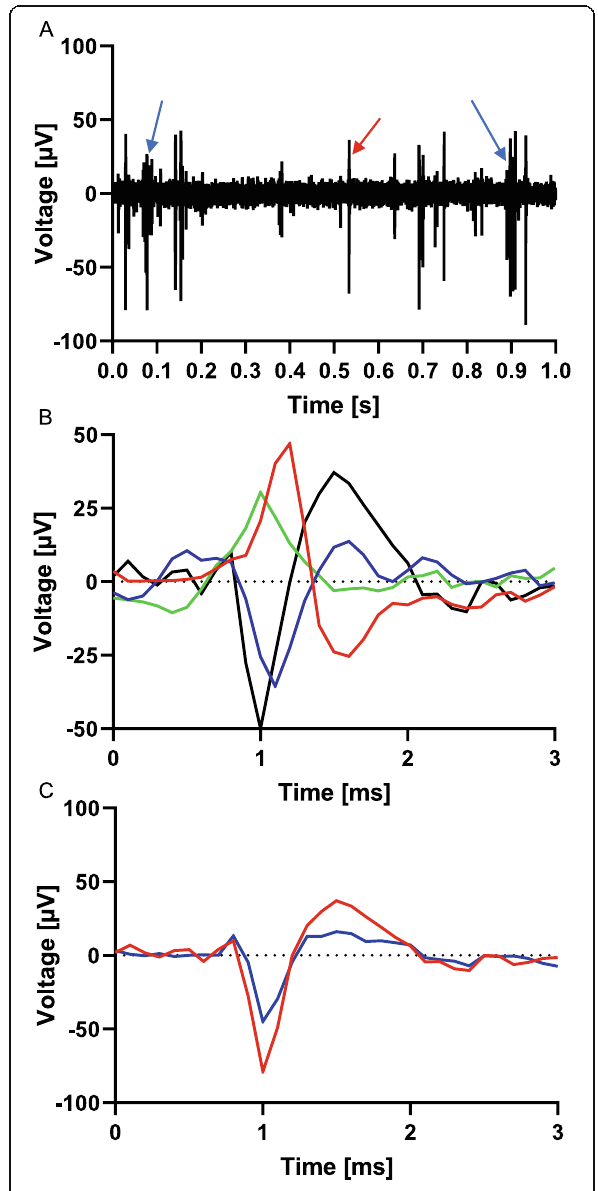
Fig. 2 Illustration of signals recorded with multielectrode arrays. A One second stream of recording from a single electrode, including single spikes (red arrow) and bursts (blue arrows). B Overlay of single spikes of different waveforms, which suggest different neuronal subtypes as the source. c Overlay of two spikes with different amplitudes but similar waveforms, either indicating different neuronal subtypes or distances of the respective spiking neurons from the recording